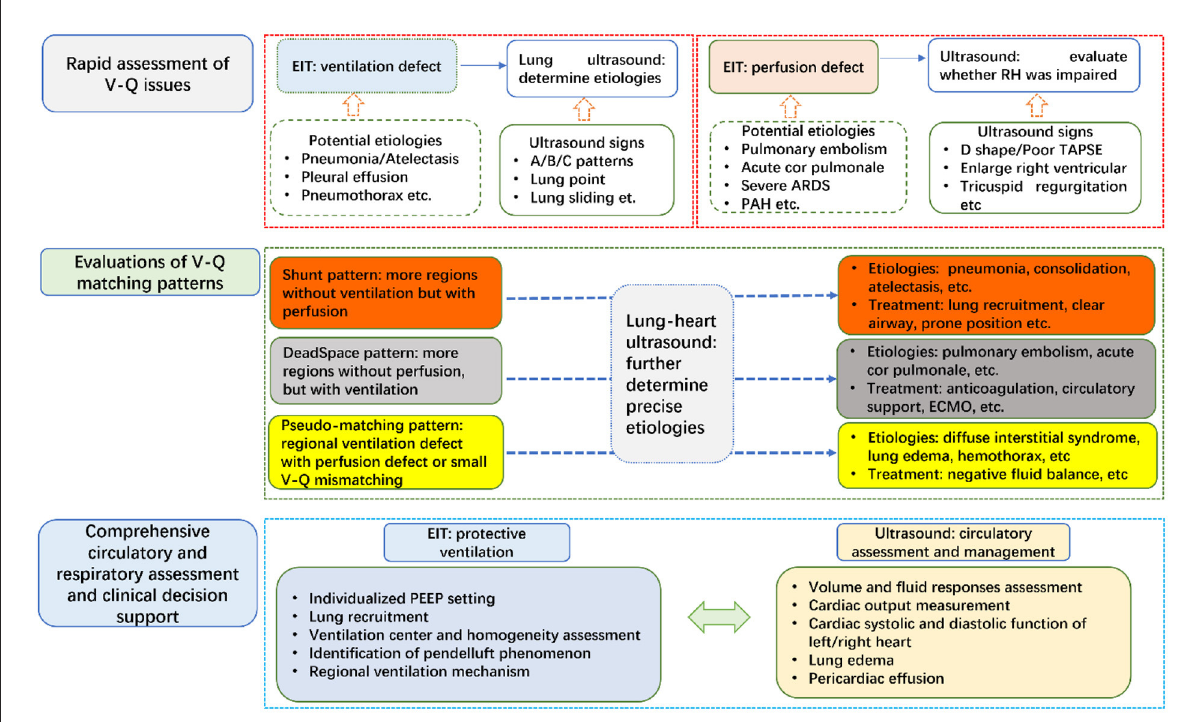
FIGURE1 Combination of chest EIT and lung ultrasound for respiratory and circulatory managements in ICU. TAPSE, Tricuspid annular plane systolic excursion; PAH, pulmonary arterial hypertension; ARDS, acute respiratory distress syndrome; V-Q, ventilation-perfusion; PEEP, positive end-expiratory pressure; ECMO, extracorporeal membrane